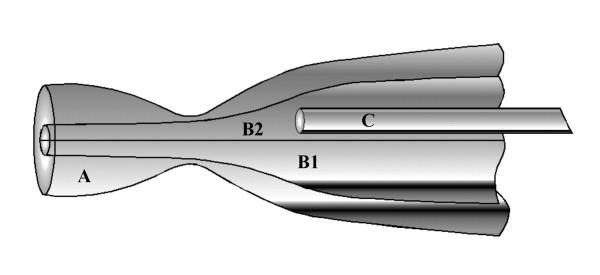
Pipette assembly for microperfusing segments of undissected bronchiole. The bronchiole is held in outer large pipette (A) by suction. An inner, septated cannulating pipette provides current passing capacity through one barrel (B1) and perfusing fluid to the duct lumen through the opposite barrel (B2), which also contains a small cannula pipette (C) that allows changes of perfusing solutions.